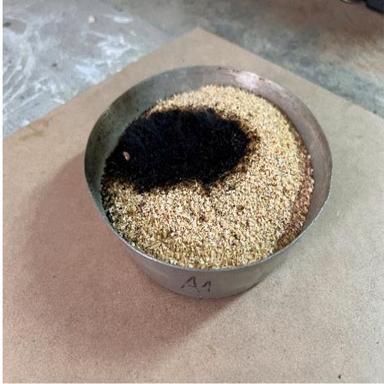
Carbonization of the material.